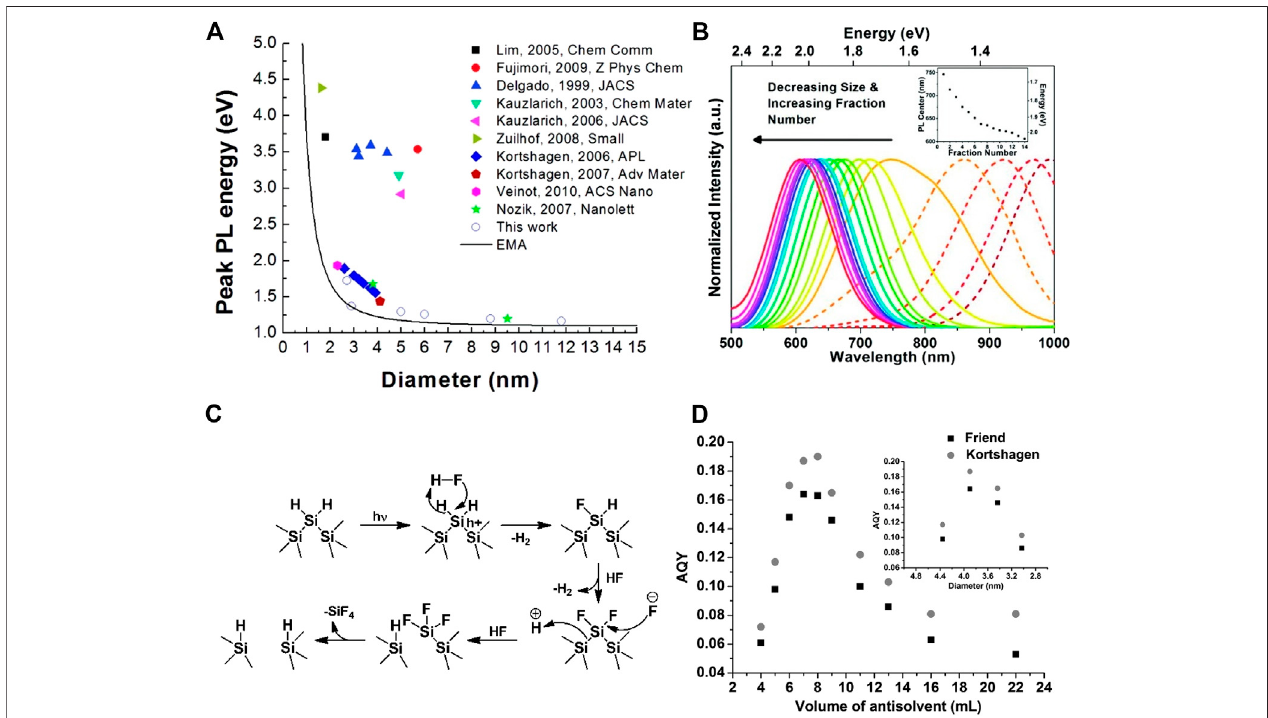
FIGURE 2 | (A) PL peak energy versus diameter of SiNCs and the curve corresponds to the effective mass approximation (EMA), reprinted with permission from Hessel etal.(2012).Copyright2012AmericanChemicalSociety. (B) PLwavelength invisiblerange(solidline)and NIR range(dashed line)versusdiameterofSiNCsand theinsetshowsthesummaryofPLcenterversusfraction number,reprintedwithpermissionfromMastronardietal.(2012).Copyright2011AmericanChemicalSociety. (C) Mechanism of the SiNCs photochemical etching by HF, reprinted with permission from Rodríguez Núñez et al., 2012. Copyright 2011 American Chemical Society. (D) AQY versus volume of antisolvent used and the corresponding size of SiNCs shown in the inset, reprinted with permission from Sun et al. (2015). Copyright 2014 WILEY-VCH Verlag GmbH & Co. KGaA, Weinheim.